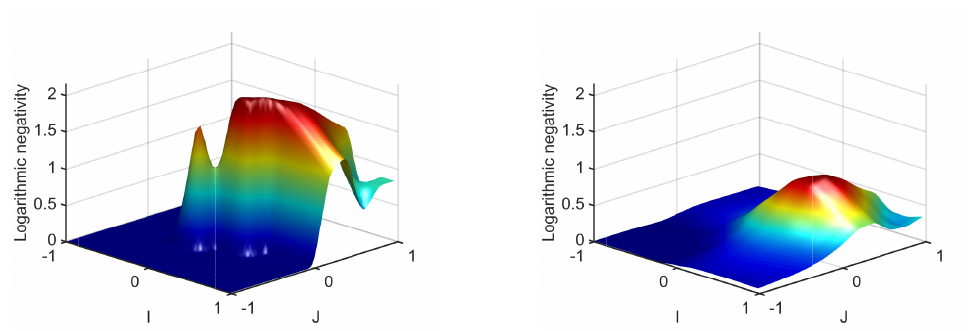
Figure 2: General view of the temperature evolution the entanglement (logarithmic negativity) for K = + 1 at zero applied field. Left panel — low-temperature regime, T = 0.005; right panel — high-temperature regime, T =